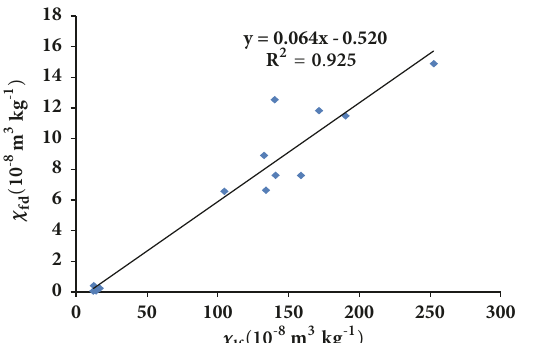
Figure 5: Interdependence between 𝜒 fd and 𝜒 lf for pastures land.